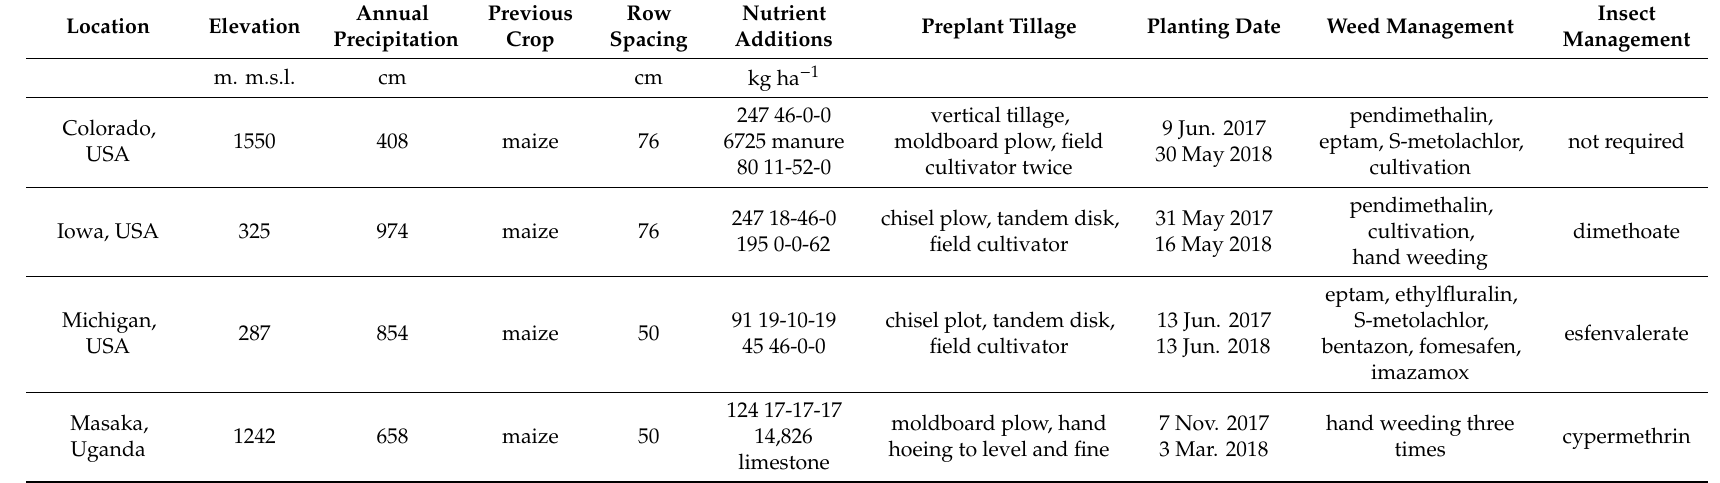
Table 1. Elevation, annual precipitation, and agronomic and pest management at four locations for production of four common bean varieties in two years.